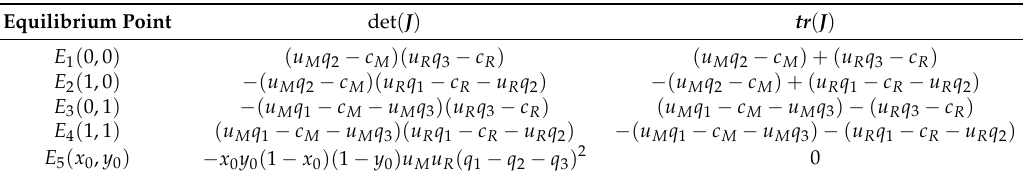
Table A1. The determinant and trace of Jacobian matrix of J the dynamic replicator system at each equilibrium point.